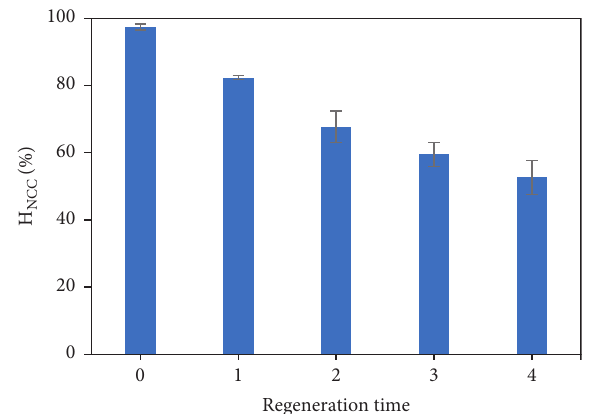
Figure 13: The NCC removal efficiency by adsorbing onto the PVBTAC-modified-regenerated α -Al 2 O 3 adsorbents with different regeneration times at optimal conditions of: C i ,NCC of 10ppm, pH 8, NaCl 10 mM, and m α -Al2O3 of 3 mg mL − 1